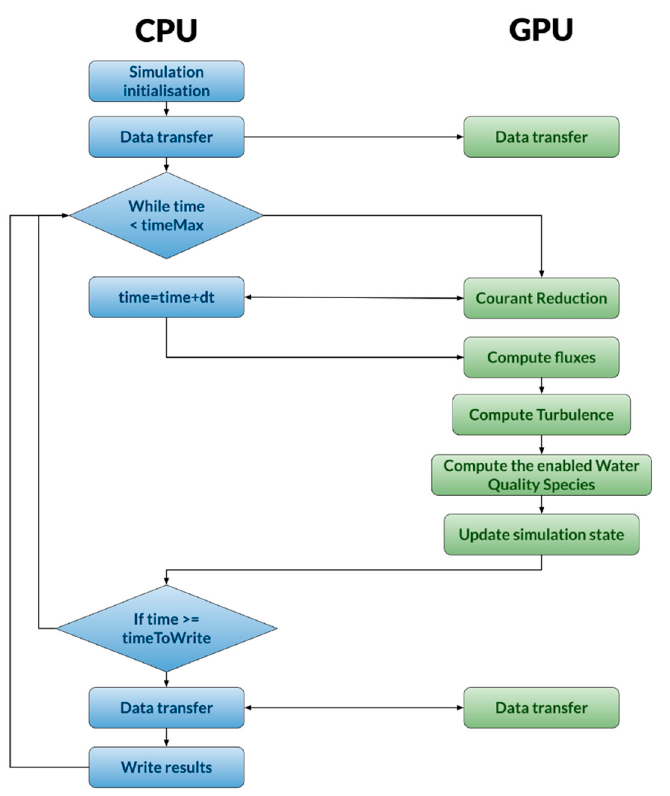
Figure 2. Flowchart of the Iber+ implementation.